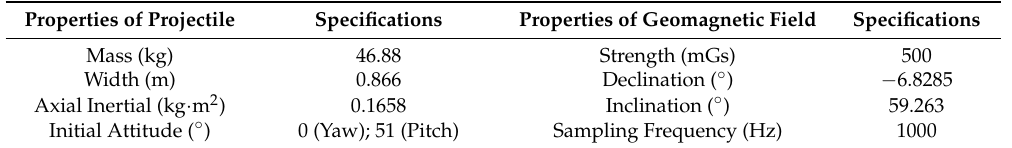
Figure 10. Model of 6-degrees of freedom (DoF) trajectory: ( a ) Trajectory of projectile and ( b ) information of the speed, pitch and yaw from 6-DoF. Table 2. Properties of projectile and